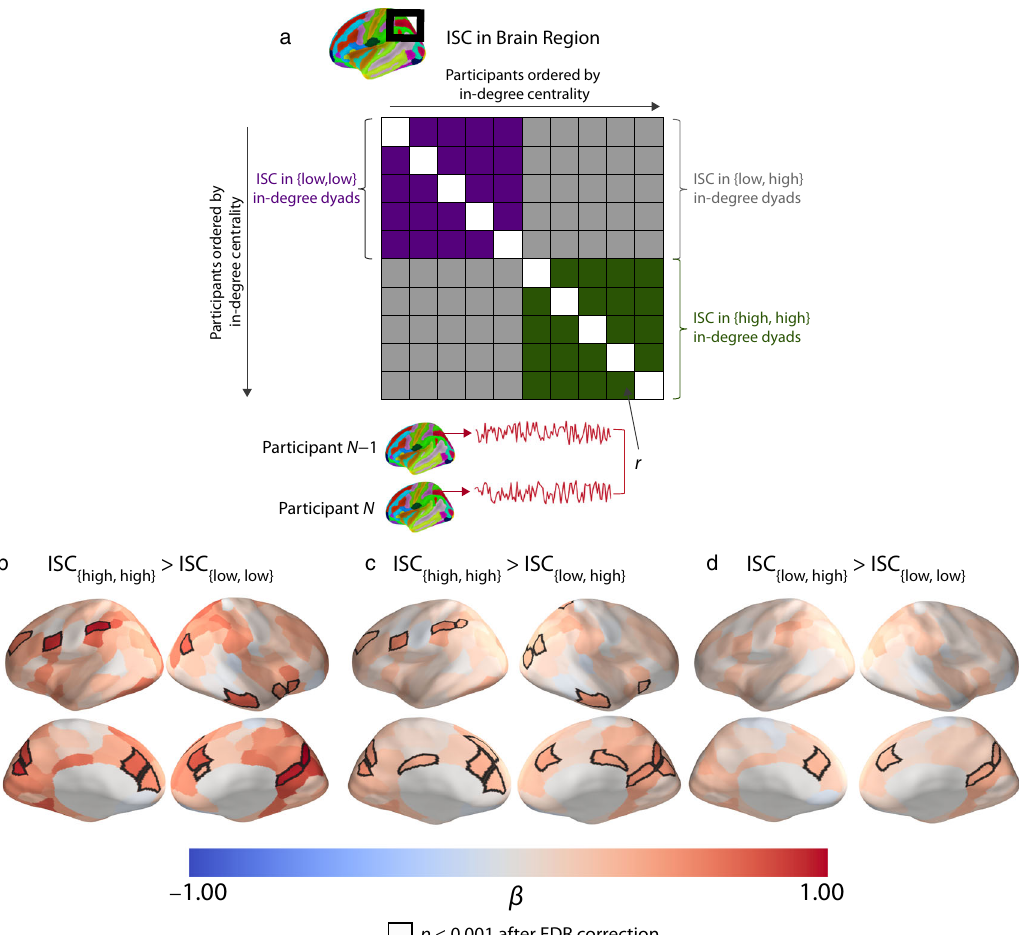
Fig. 4 Dyad-level analysis and results. a Dyad-level ISCs in a brain region are encoded in a matrix whose entries consist of pairwise Pearson correlation coef fi cients. The rows and columns of the matrix are ordered according to the in-degree centralities of the participants. We performed planned contrasts of the different centrality groups to test whether dyads in which both individuals were highly central (i.e., ISC {high,high} ) , had larger ISCs than dyads in which both individuals were less central (i.e., ISC {low,low} ) and than dyads with mixed centralities (i.e., ISC {low,high} ), for which one individual of the dyad had a low centrality and the other had a high centrality. [The fi gure in ( a ) is adapted from prior work 34 .] b There were larger ISCs in the DMPFC, VMPFC,VLPFC, precuneus, temporal pole, and portions of the superior parietal lobule in {high, high} dyads than in {low, low} dyads. c We found similar patterns when we compared {high, high} dyads to {low, high} dyads and d when we compared {low, high} dyads to {low, low} dyads. The ISC {high,high} > ISC {low,low} contrast in ( b ) provides the most direct test of our main hypotheses that highly-central individuals have similar neural responses to one another and that less- central individuals have neural responses that are idiosyncratic. The quantity β is the standardized regression coef fi cient. Regions with signi fi cant differences for each contrast are outlined in black. We used an FDR-corrected signi fi cance threshold of p < 0.001, which corresponds to an uncorrected p -value threshold of p < 6.386 × 10 − 5 . All of the reported p -values are two-tailed. Source data are provided as a Source Data fi